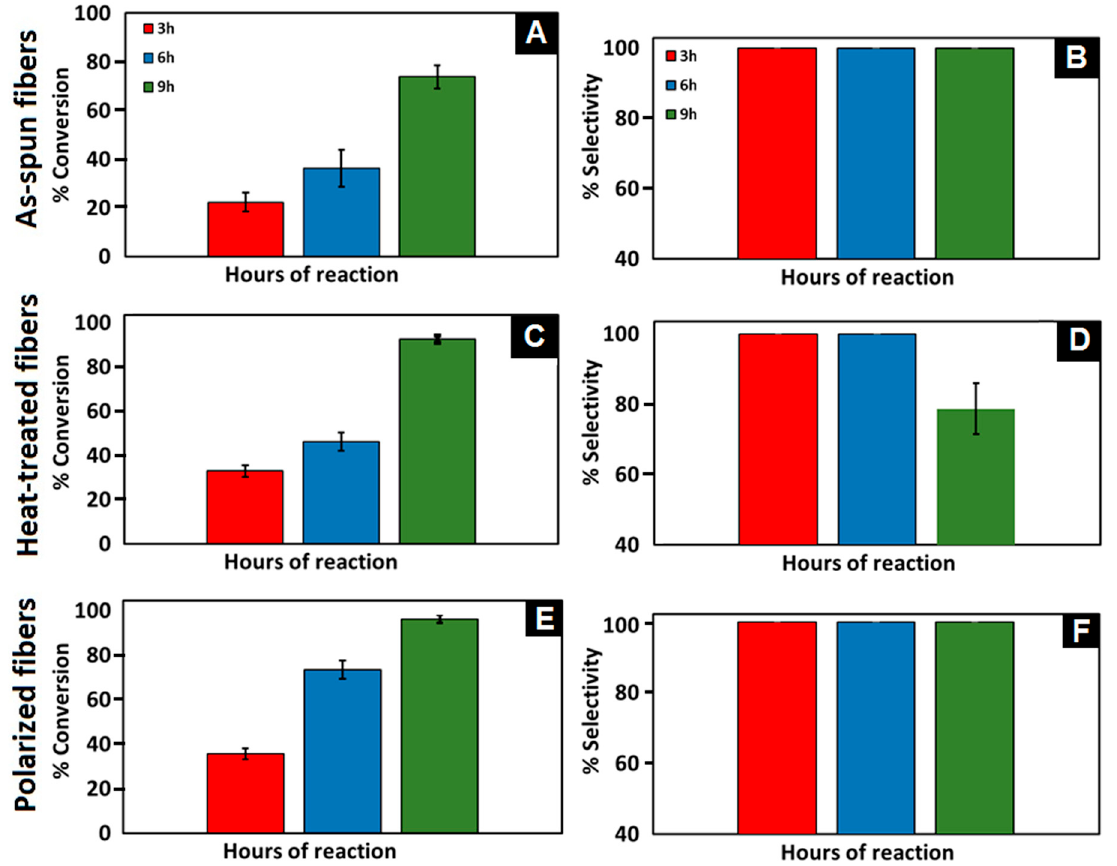
Figure 10. Conversion of phenol ( A , C , E ) and selectivity of cyclohexanone ( B , D , F ) using as-spun, heat-treated, and polarized Pd/PVDF electrospun fibers.